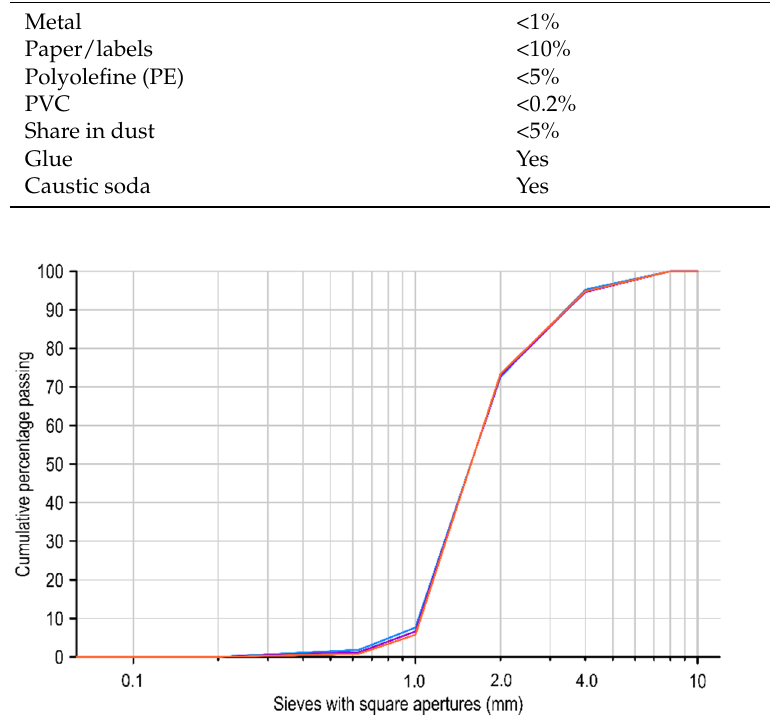
Figure 2. Grading curves for washed PET fines. The grading curves of PET aggregate indicated that the particle size distribution for individual samples was nearly identical, and slight differences could be observed for the finest fractions. Fractions above 4.0 mm constituted approximately 5% of the material composition; fractions between 2.0 and 4.0 mm constitute 20% of the material; the largest fraction was between 1.0 and 2.0 mm, which represented almost 70% share; and the remaining 5% were fractions below 1.0 mm. The entire material was divided into three main fractions (above 4.0 mm, 2.0 to 4.0 mm, and below 2.0), as shown in Figure